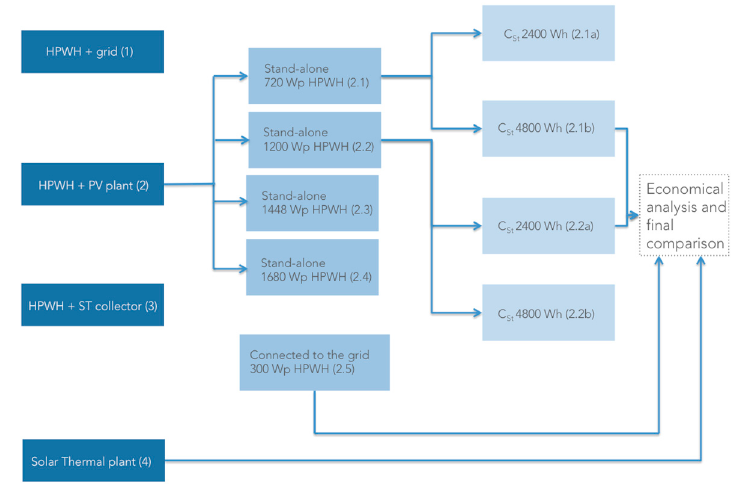
Figure 2. Scheme of the simulated plants.